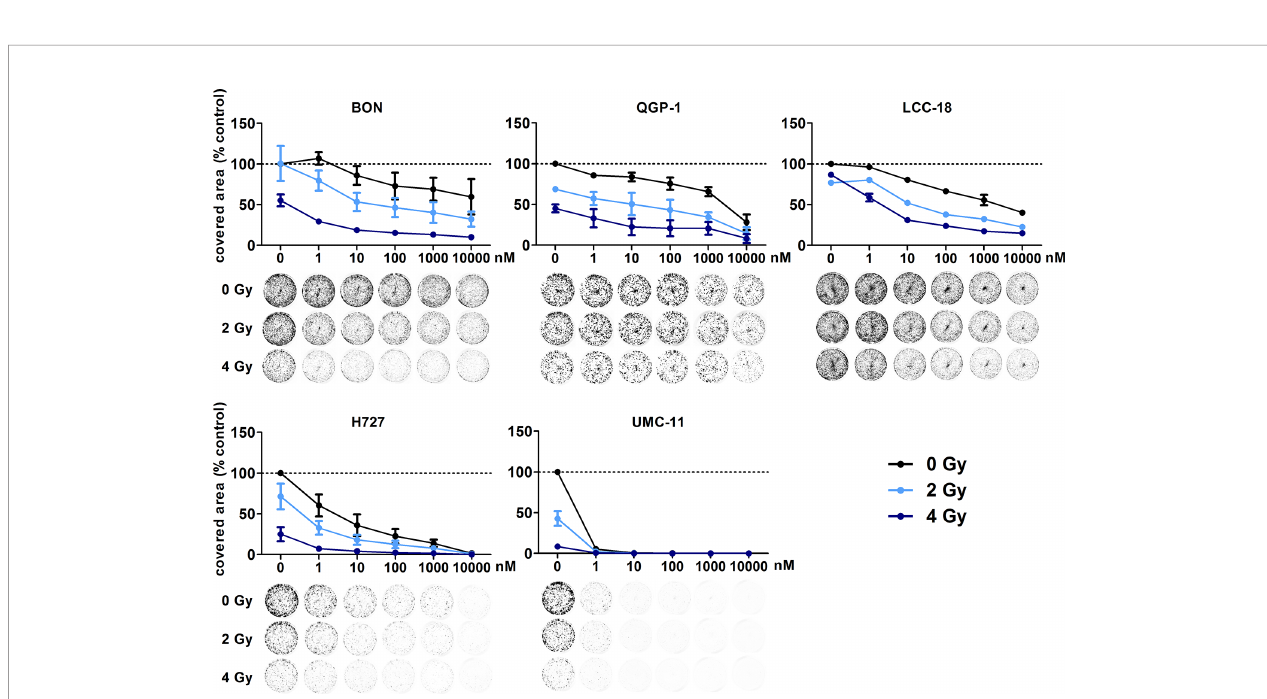
FIGURE 8 | Additive effect of temsirolimus and irradiation on NEN cell survival. NEN cell lines were seeded at low density, treated with increasing concentrations of temsirolimus for 24 h before irradiation with 0 – 4 Gy. Cells were incubated for 1 – 2 weeks until colony formation. Data were normalized to untreated controls and represent mean ± S.E.M. (n=2 –